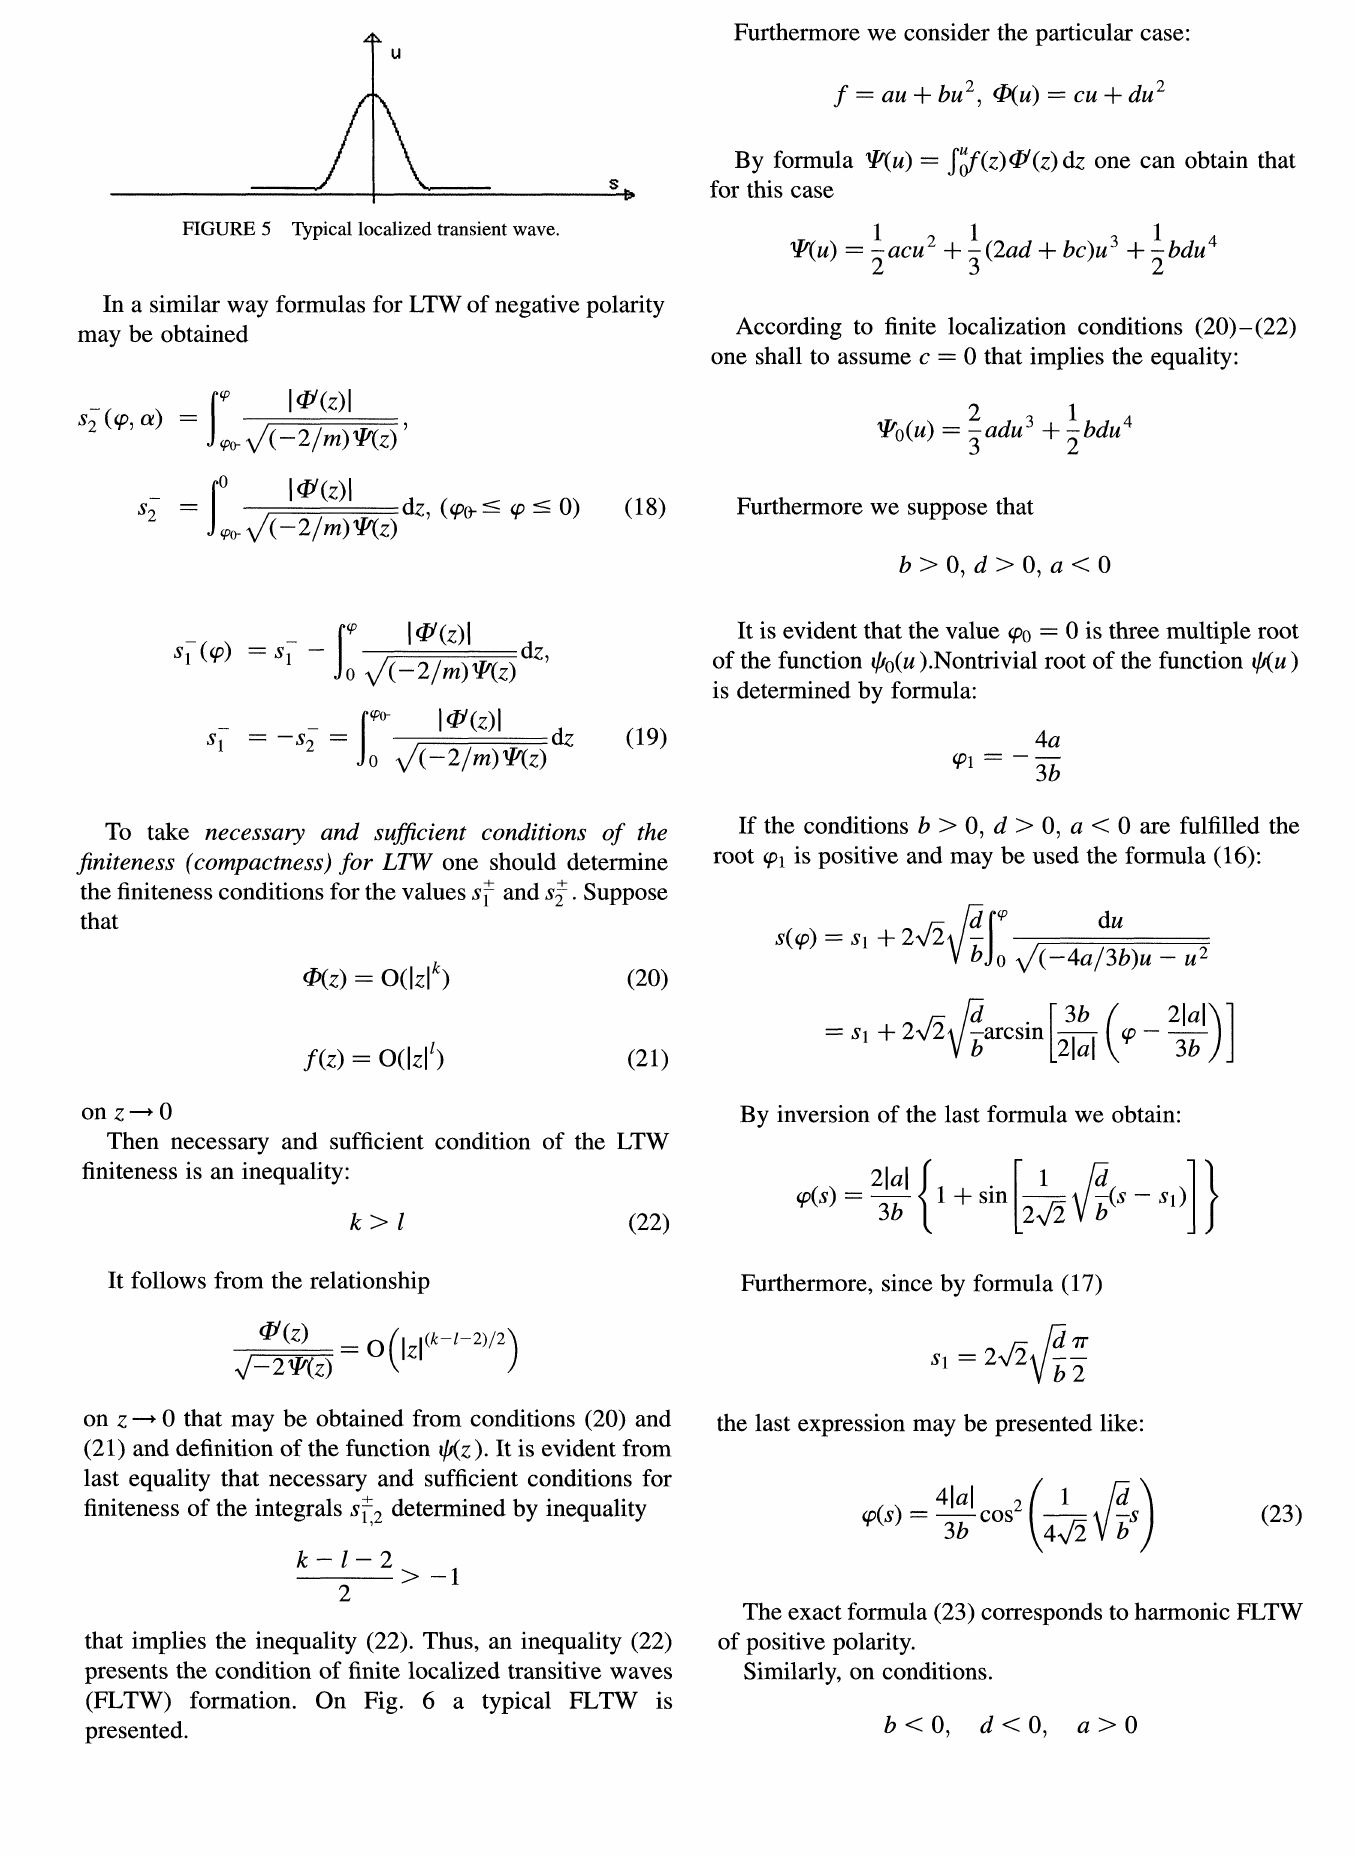
FIGURE 5 Typical localized transient